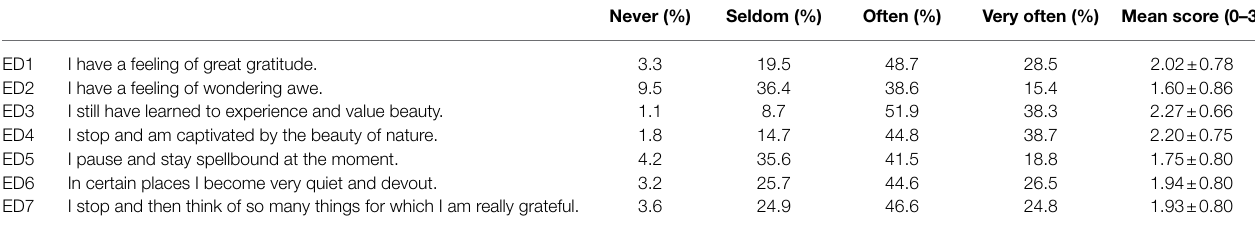
TABLE 2 | Expression of wondering awe indicators in the sample.